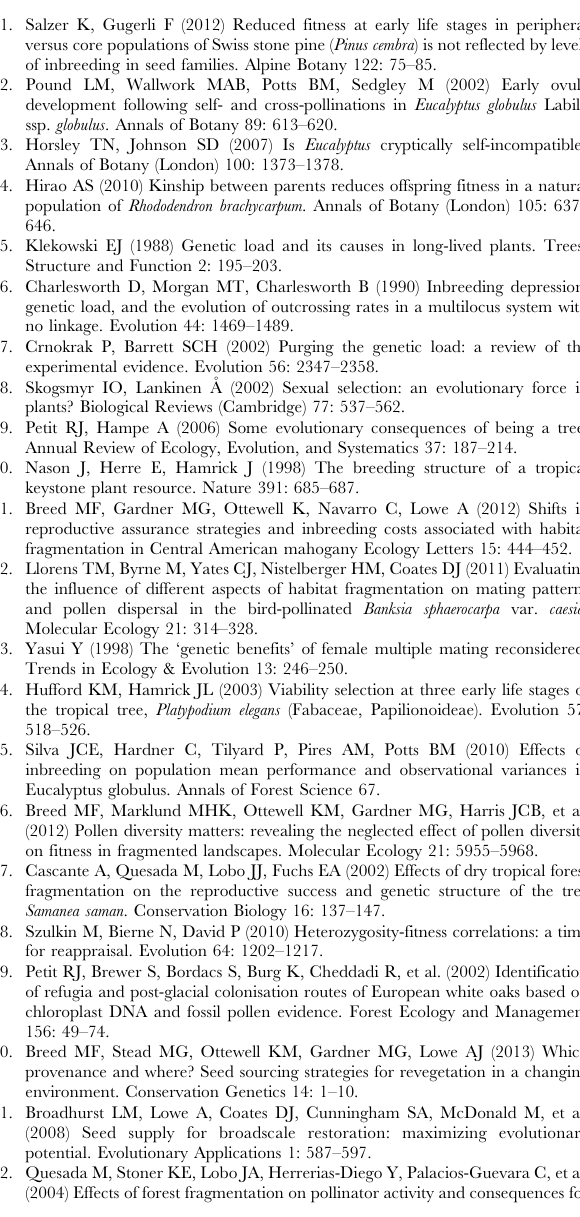
Table S6 Rainfall observations collected from the closest weather stations to the planting sites with data extending . 100